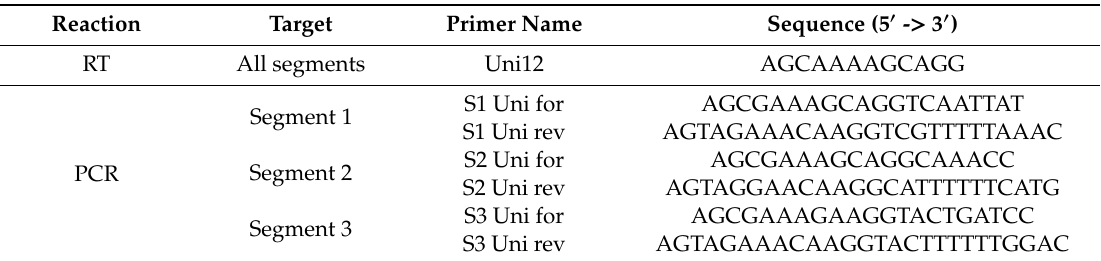
Table 1. Primers for single-cell reverse transcription polymerase chain reaction